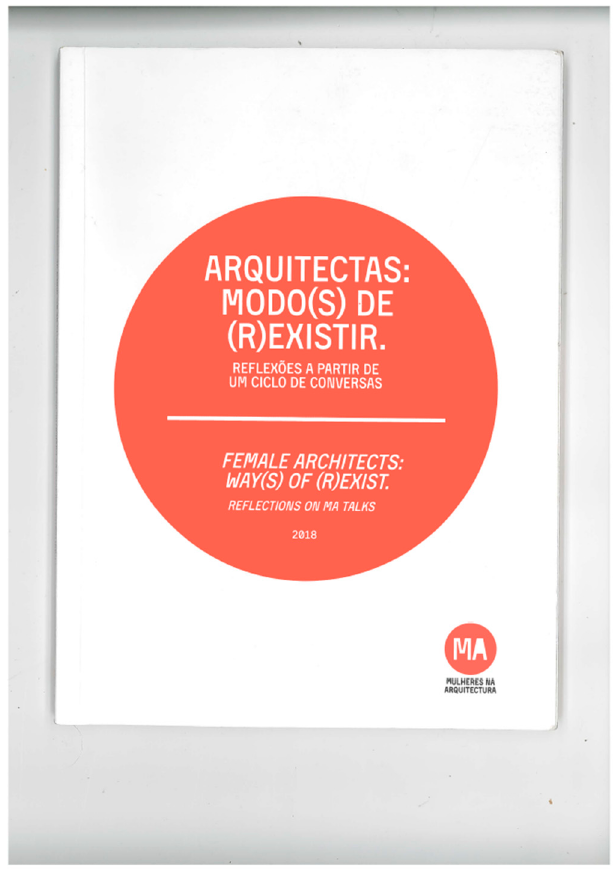
Figure 1. Book cover. Used with permission.